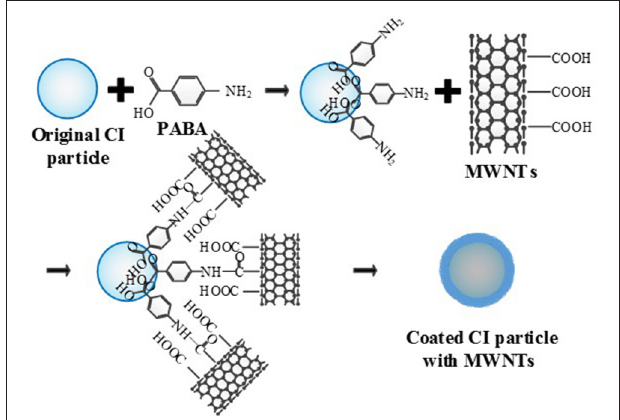
FIGURE 1 | The schematic diagram of the grafting